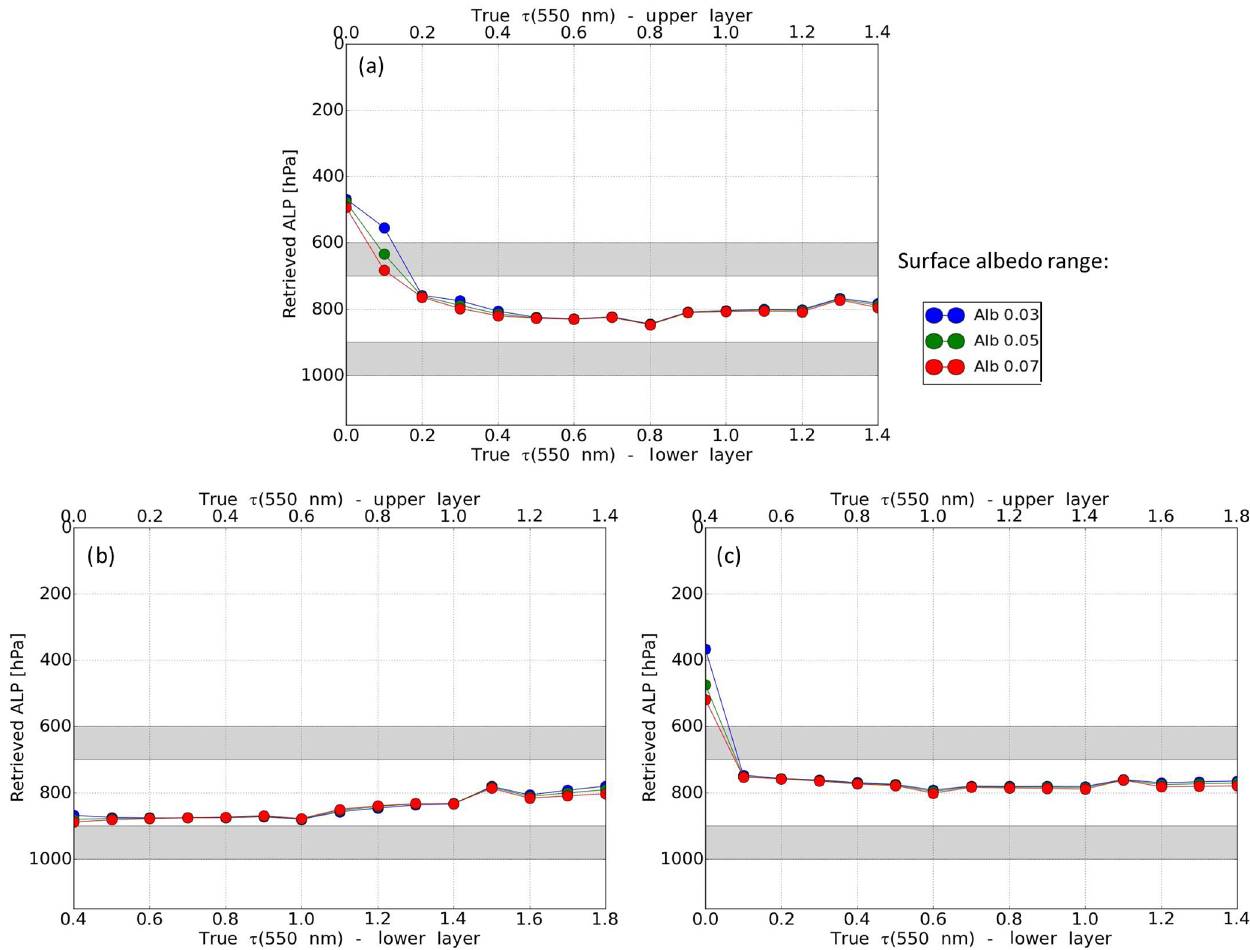
Figure 12. Same as Fig. 10 but with one unique aerosol ω 0 value ( = 0 . 9) and two separate aerosol layers included in the simulated spectra. The bottom x axis corresponds to the τ( 550nm ) value of the lower layer, while the top x axis is the τ( 550nm ) value of the upper layer. Both layers have same geometric thickness (i.e. 100hPa). The first is located between 600 and 700hPa, and the second is between 900 and 1000hPa. (a) Both aerosol layers have same optical properties and τ( 550nm ) values. (b) Both aerosol layers have same optical properties but different τ( 550nm ) values: the lower layer has systematically a higher τ( 550nm ) (i.e. + 0 . 4 for each scenario). (c) Both aerosol layers have same optical properties but different τ( 550nm ) values: the upper layer has systematically a higher τ( 550nm ) (i.e. + 0 . 4 for each